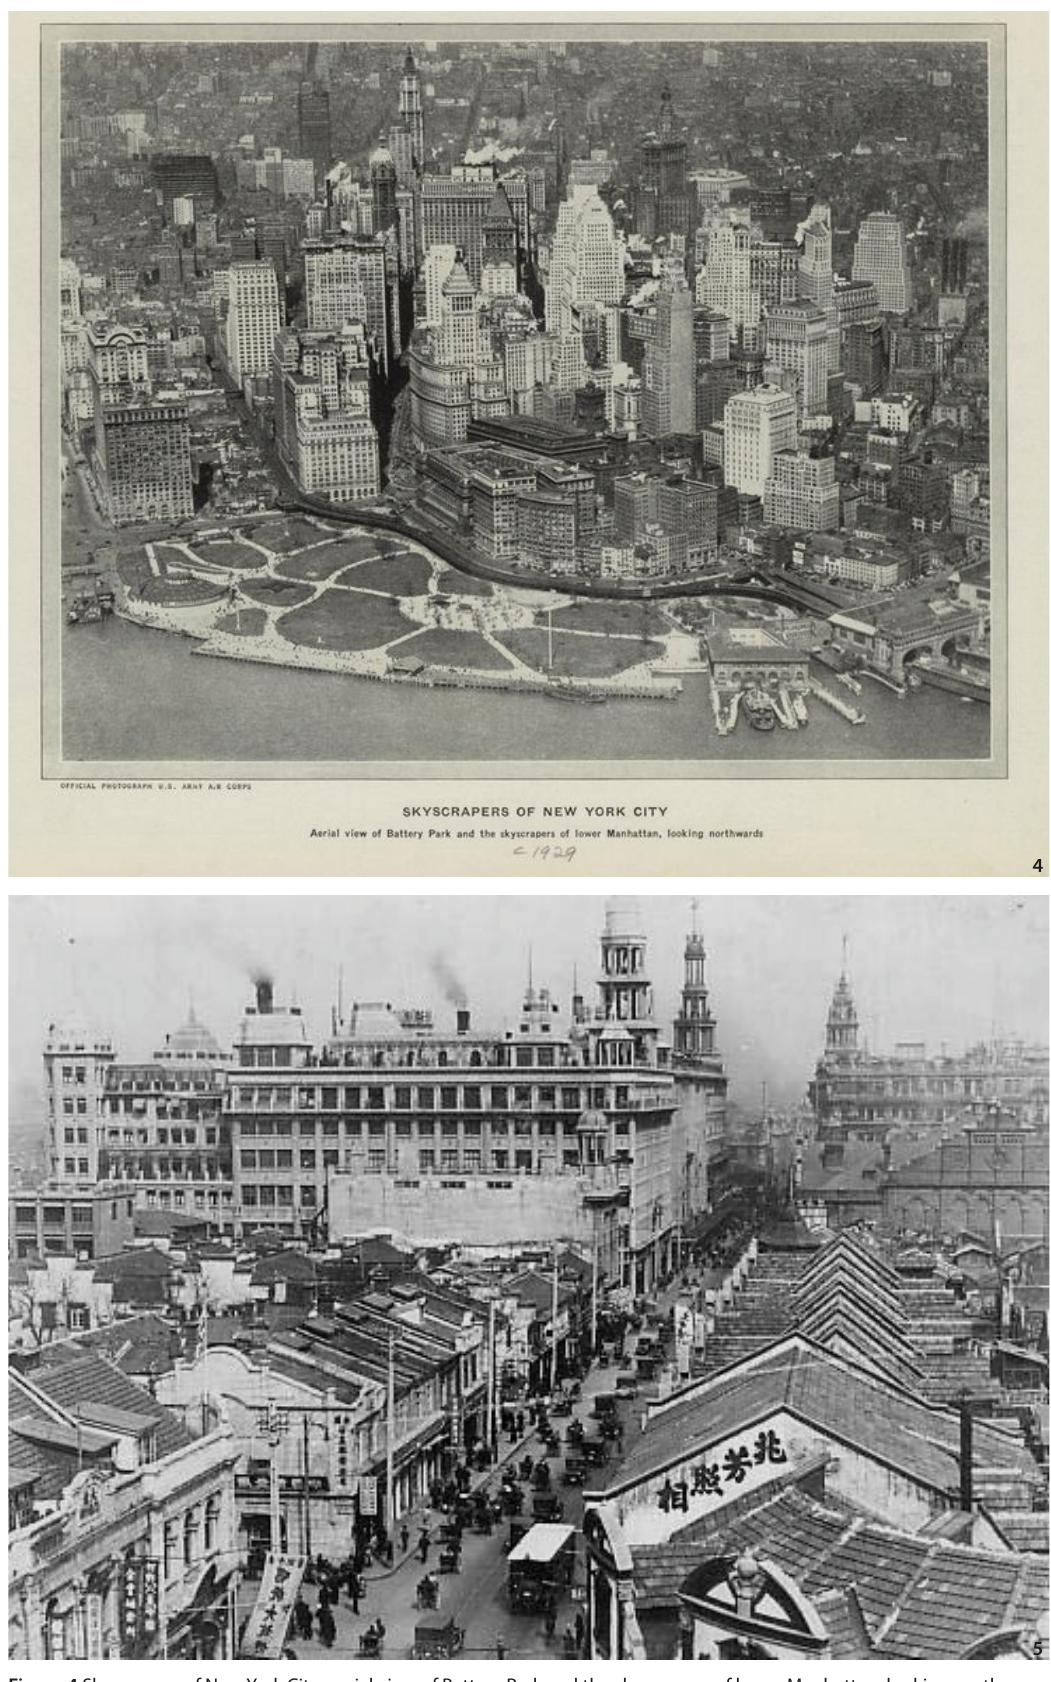
Figure 4 Skyscrapers of New York City: aerial view of Battery Park and the skyscrapers of lower Manhattan, looking north- wards, 1929 (Source: New York Public Library Digital Collections. Accessed June 26, 2019). Figure 5 Nanjing Road (Source: Japanese book Nostalgia for Shanghai published by